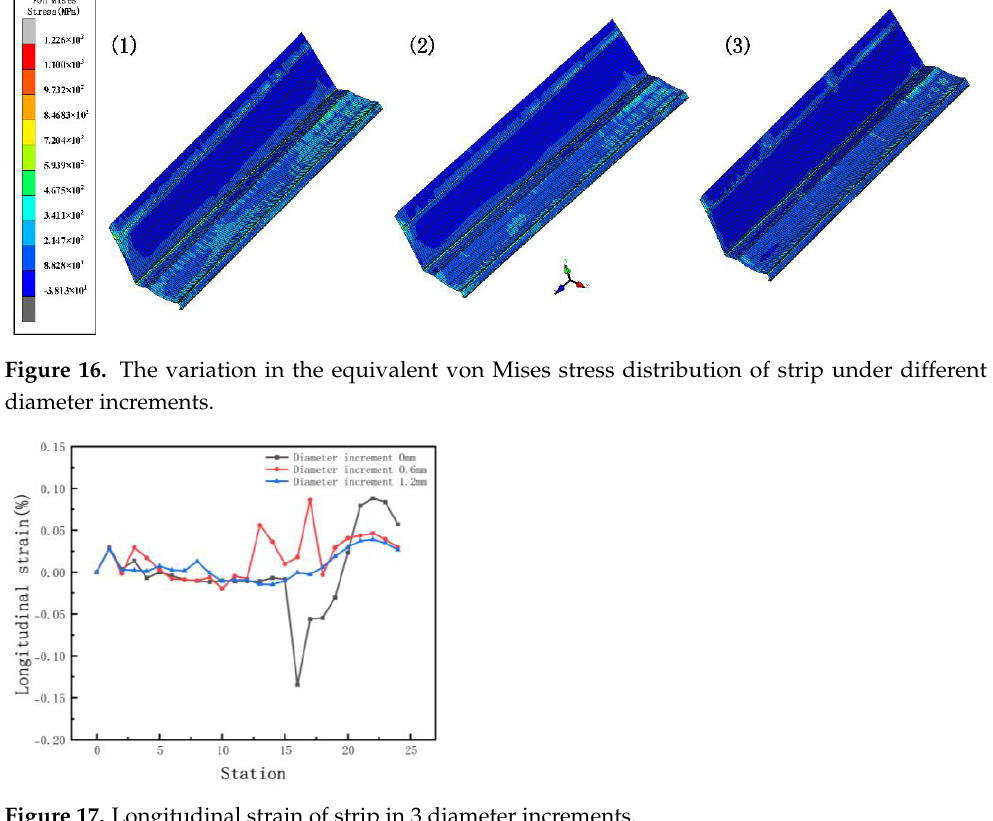
Figure 18. ( a ) Displacement X of strip in 3 diameter increments; ( b ) cross – section of 3 diameter in- crements. 4.5. Line Velocity In order to investigate the influence on line velocity, we set the velocities at 5, 10, and 15 rpm, respectively. Other parameters include inter – distance 800 mm, friction 0.1, and diameter increment 0.6 mm. Figure 19 shows the equivalent stress of the different veloci- ties. The difference in equivalent stress is small and has less impact on the stability, be- cause the absolute values of stresses are distributed in the range of 38.13 to 467.5 MPa. Positive and negative numbers indicate only stretching or compression behavior. Figure 20 shows the longitudinal strain at the same location on the edge. The effect of velocity on longitudinal strain is less when forming horizontally. There is a significant increase in longitudinal strain at elevated sides. When the speed is too fast, the strain rate increases, which leads to work hardening, and the internal strengthening requires greater forces during deformation.